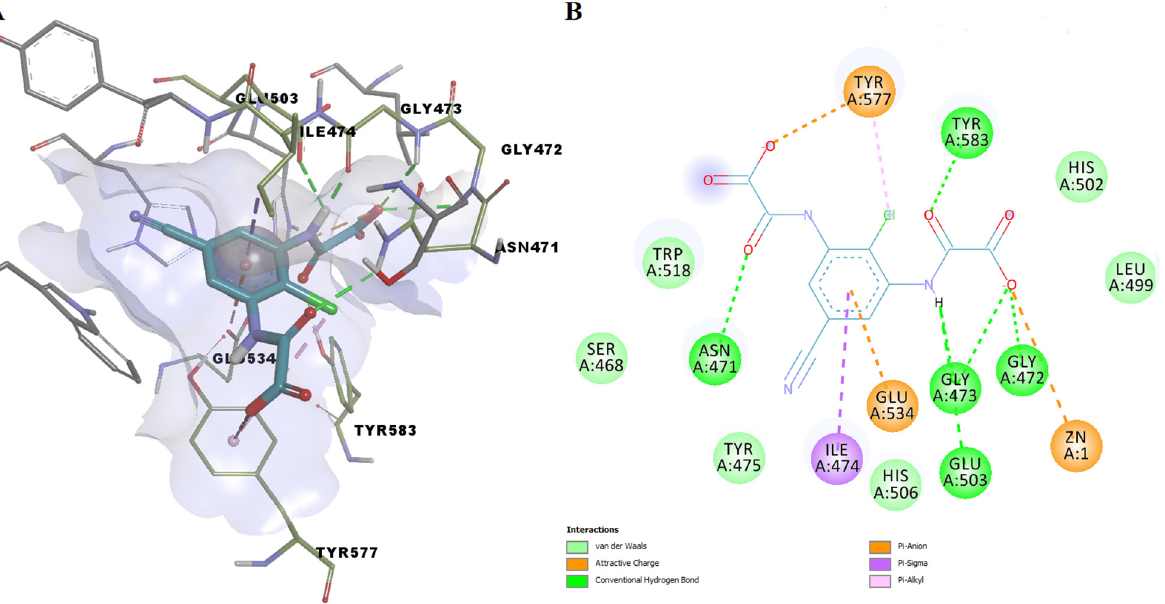
Figure 9. ( A ) 3D binding pose of lodoxamide into ColA active site; ( B ) 2D molecular interactions diagram for lodoxamide-ColA complex.